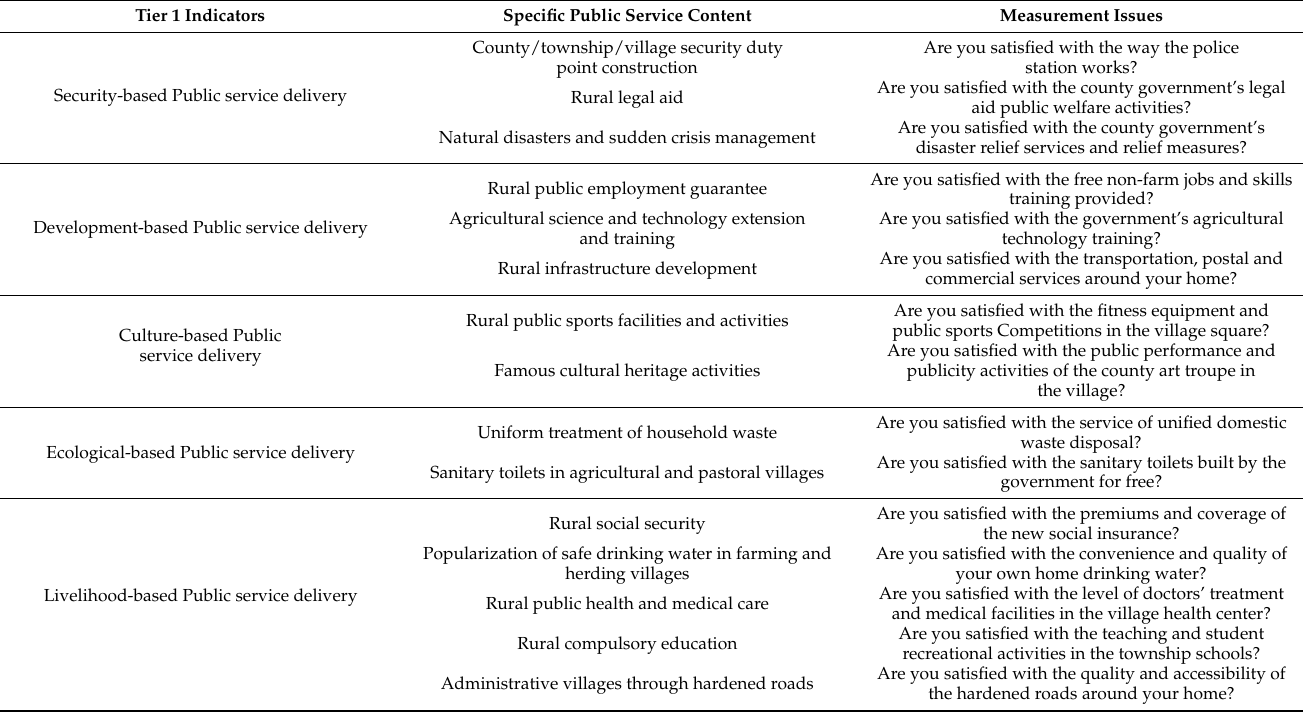
Table 2. Public service satisfaction